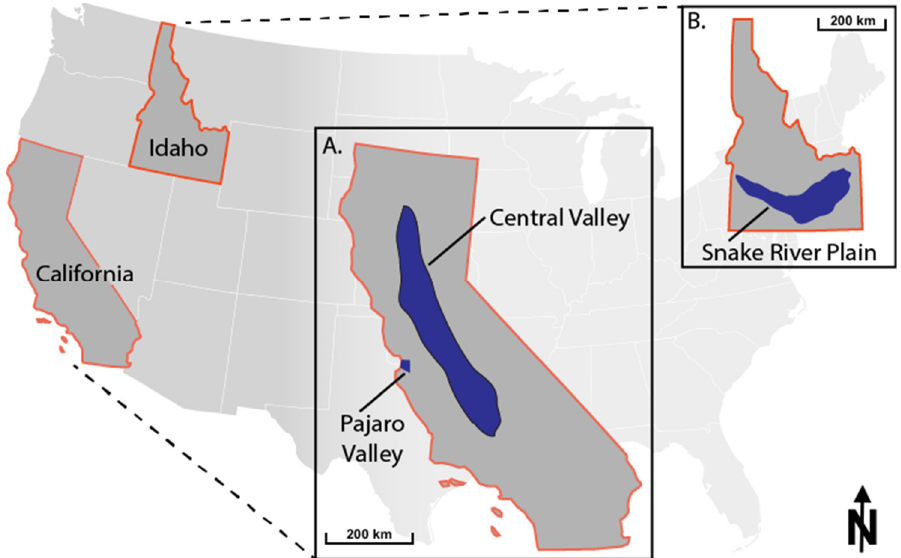
Figure 1. Areas of interest in the United States, including the Central Valley and Pajaro Valley in California ( A ), and the Snake River Plain in Idaho ( B ).